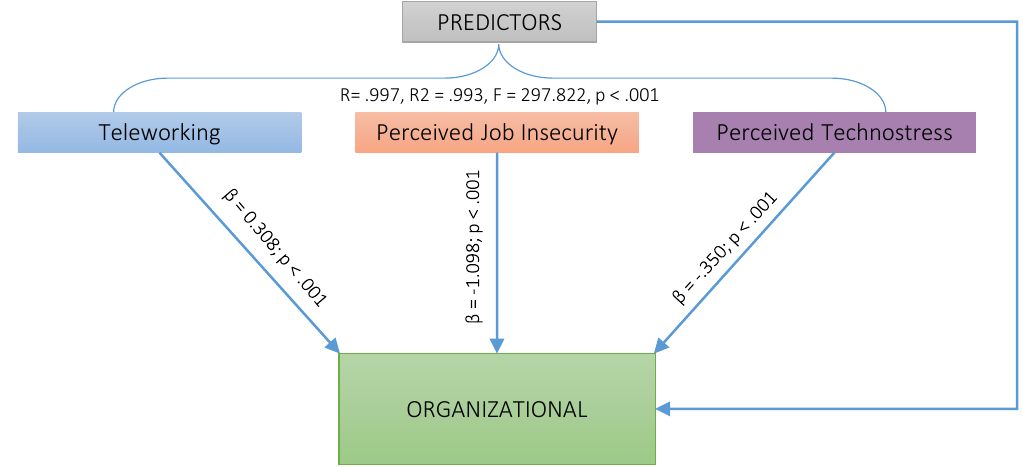
Figure 1. Joint and individual impact of TW, TS, and JI on OP in Nigeria’s business